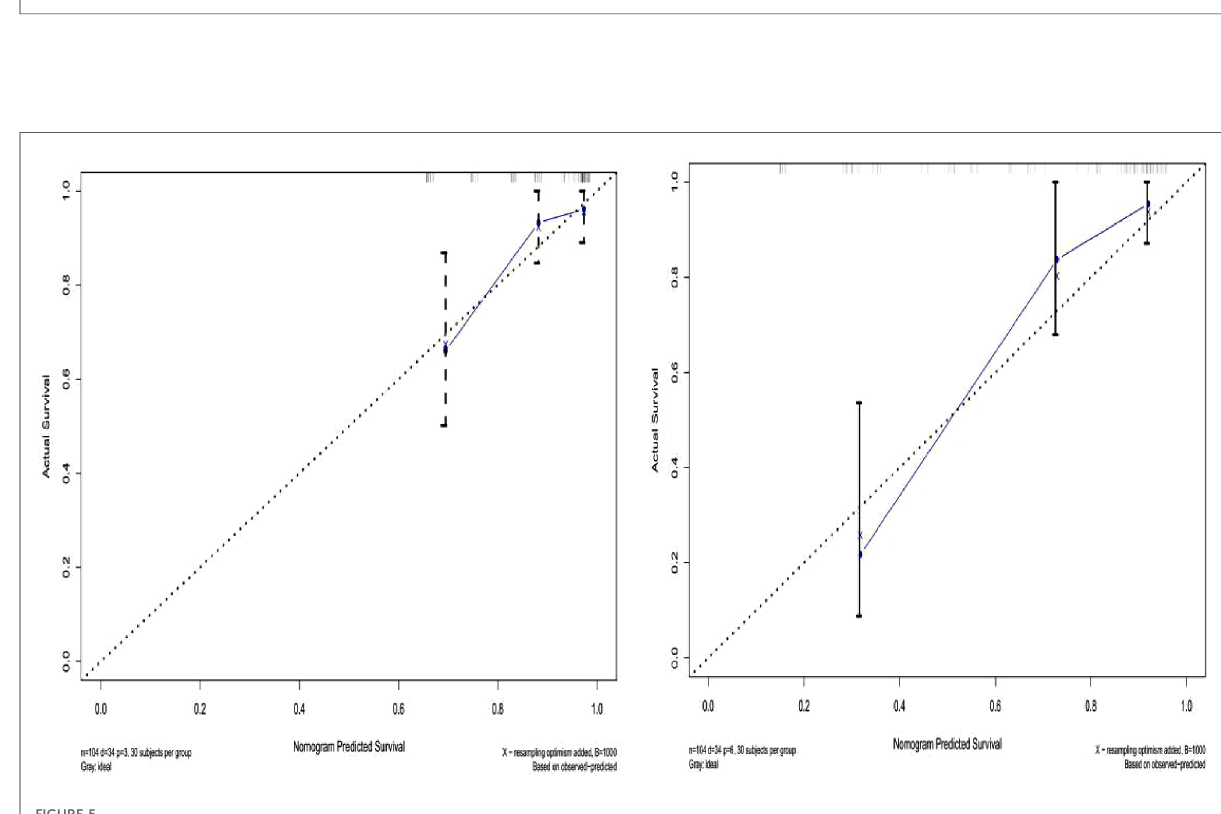
FIGURE 4 Survival calibration curve of patients with hepatic alveolar echinococcosis. A is 3-year survival, B is 5-year survival, and the probability of nomogram- predicted overall survival is plotted on the x -axis; actual overall survival is plotted on the y -axis.